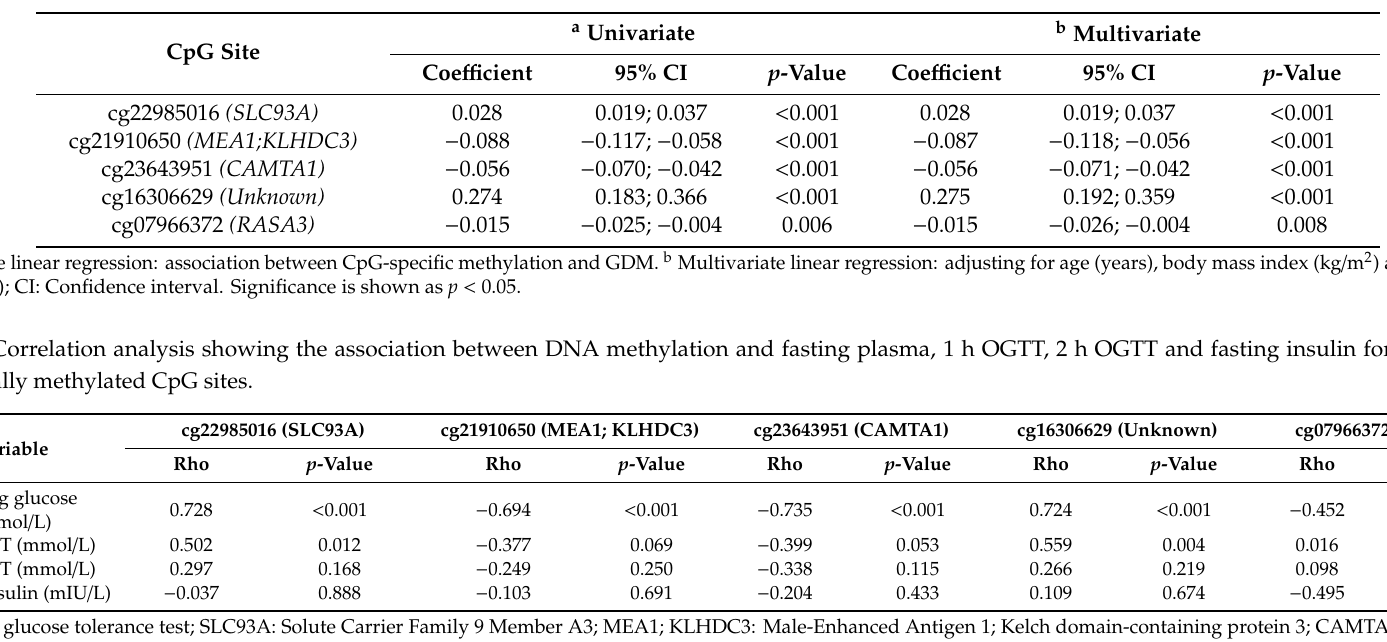
Table 3. Linear regression analysis of gestational diabetes mellitus and the top five significantly di ff erentially methylated CpG sites, adjusting for age, body mass index and gestational age.